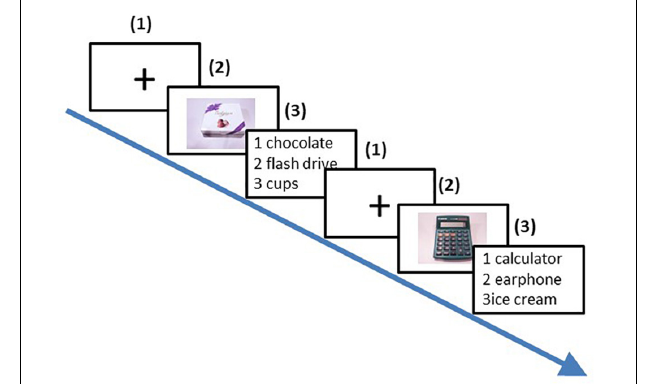
FIGURE 1 | Viewing task procedure (Two trials). (1) A fixation screen was displayed for a random duration (800-1, 700 ms); (2) A picture of the product was presented for 3 s; (3) Participants indicated with a key press which description matched the product seen in slide (2). No time limit was imposed. This procedure was repeated for every picture of every product, resulting in 360